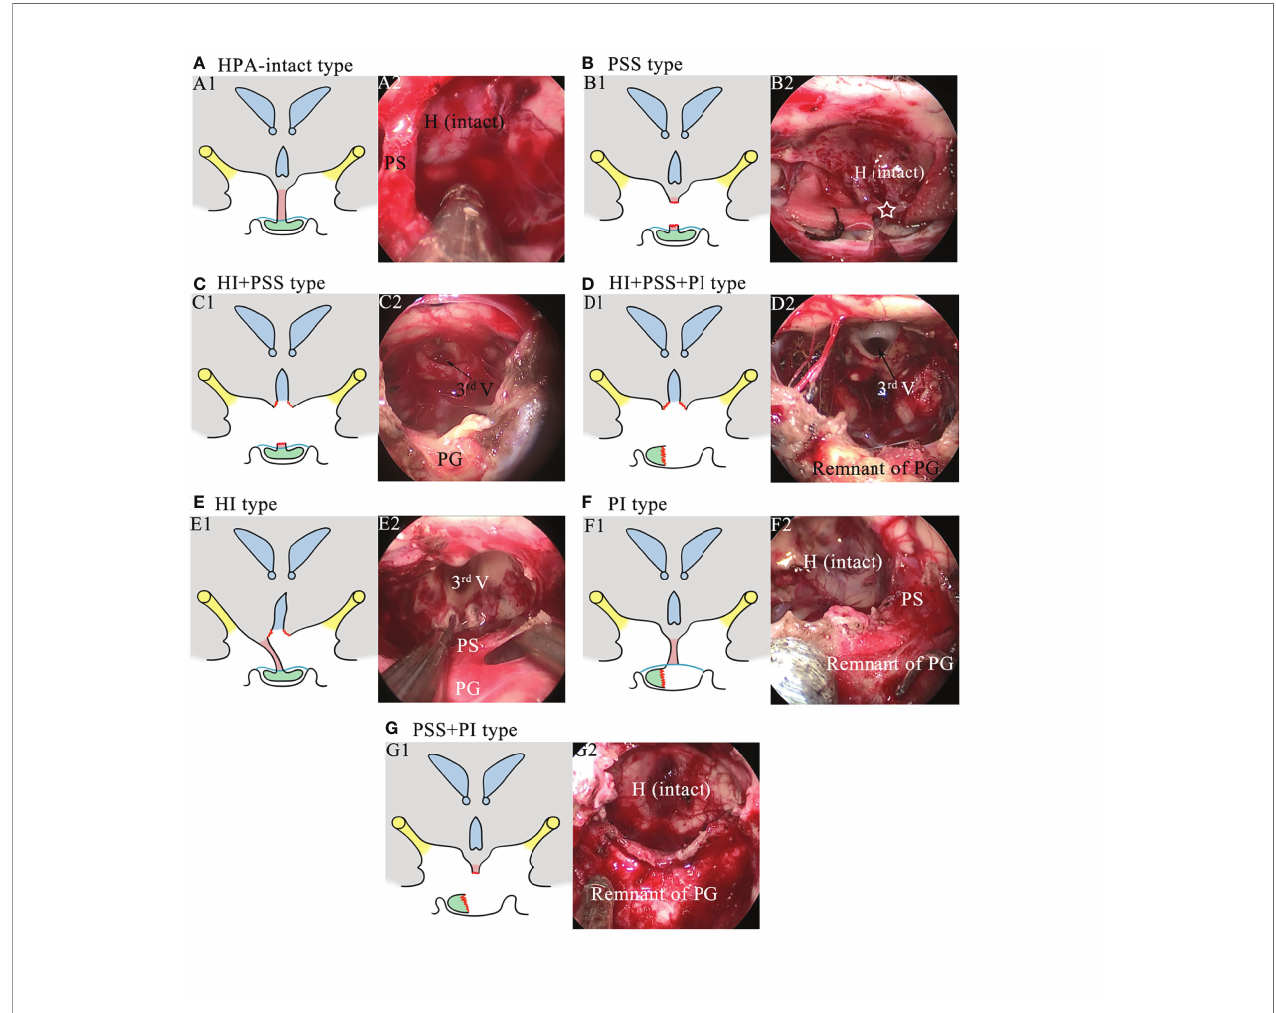
FIGURE 1 | Schematics and intraoperative images showing the injury types of the hypothalamus – pituitary axis. (A) Schematic of the HPA-intact type (A1) and the corresponding intraoperative image (A2). The hypothalamus, the pituitary stalk, and the pituitary gland are intact. H, hypothalamus; PS, pituitary stalk. (B) Schematic of the PSS type (B1) and the corresponding intraoperative image (B2). The pituitary stalk is resected, while the hypothalamus and the pituitary gland are intact. The white star represents the stalk proximal stump. (C) Schematic of the HI+PSS type (C1) and the corresponding intraoperative image (C2). The third ventricle fl oor is open, and the pituitary stalk is resected, while the pituitary gland is intact. 3rd V, the third ventricle; PG, pituitary gland. (D) Schematic of the HI+PSS+PGI type (D1) and the corresponding intraoperative image (D2). The third ventricle fl oor is open, the pituitary stalk is resected, and the pituitary gland is injured, rendering a remnant of the pituitary gland. (E) Schematic of the HI type (E1) and the corresponding intraoperative image (E2). The third ventricle fl oor is open, while the pituitary stalk and the pituitary gland are preserved. (F) Schematic of the PGI type (F1) and the corresponding intraoperative image (F2). The pituitary gland is injured, while the hypothalamus and the pituitary stalk are preserved. (G) Schematic of the PSS+PGI type (G1) and the corresponding intraoperative image (G2). The hypothalamus is intact, while the pituitary stalk is resected and the pituitary gland is injured, rendering a remnant of the pituitary